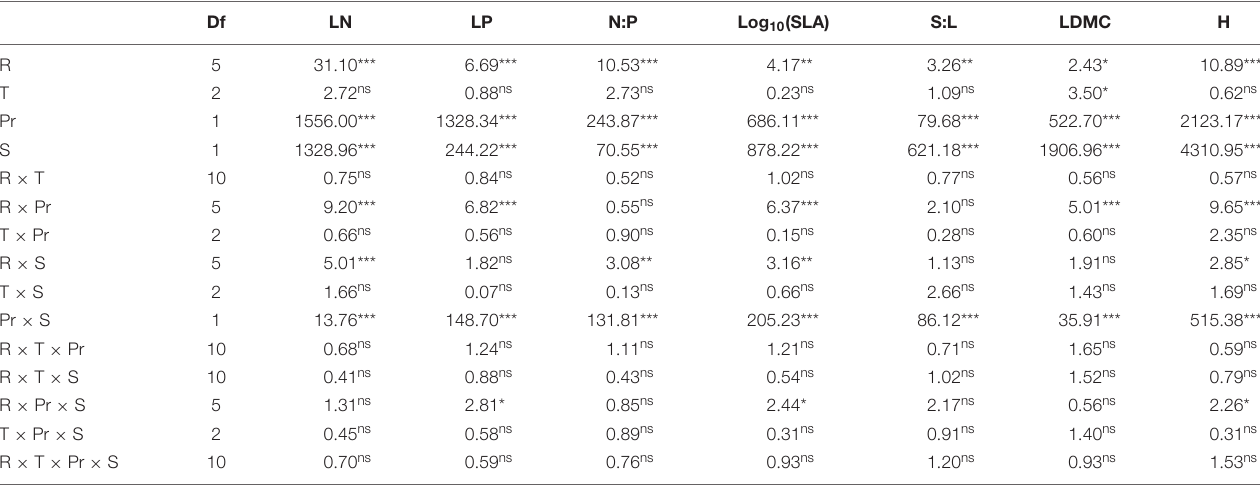
TABLE 1 | Results ( F values) of a repeated-measures ANOVA for the effects of N addition rate (R), N compounds type (T), period (Pr), species (S) and their interactions on leaf nitrogen content (LN), leaf phosphorus content (LP), leaf N content and leaf P content ratio (N:P), specific leaf area (SLA), leaf-stem ratio (S:L), leaf dry matter content (LDMC), and plant height (H) of Leymus chinensis and Thermopsis lanceolata